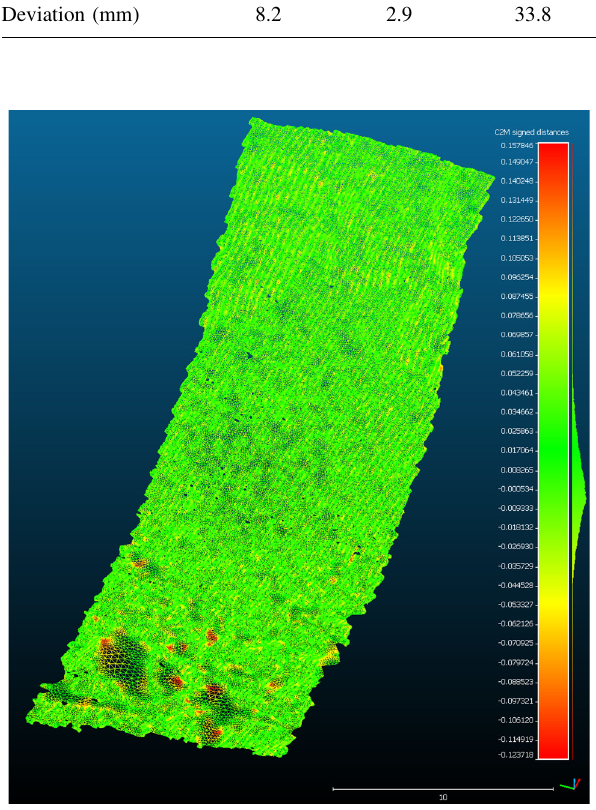
Fig. 10 Deviation between original mesh BF and optimized mesh BF